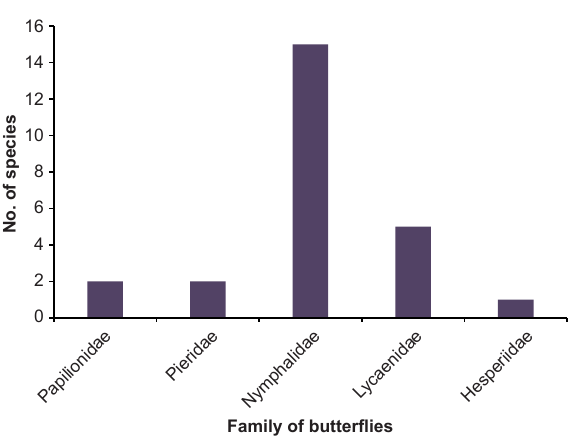
Figure 1: Family-wise number of butterfly species foraging for nectar on Wendlandia tinctoria